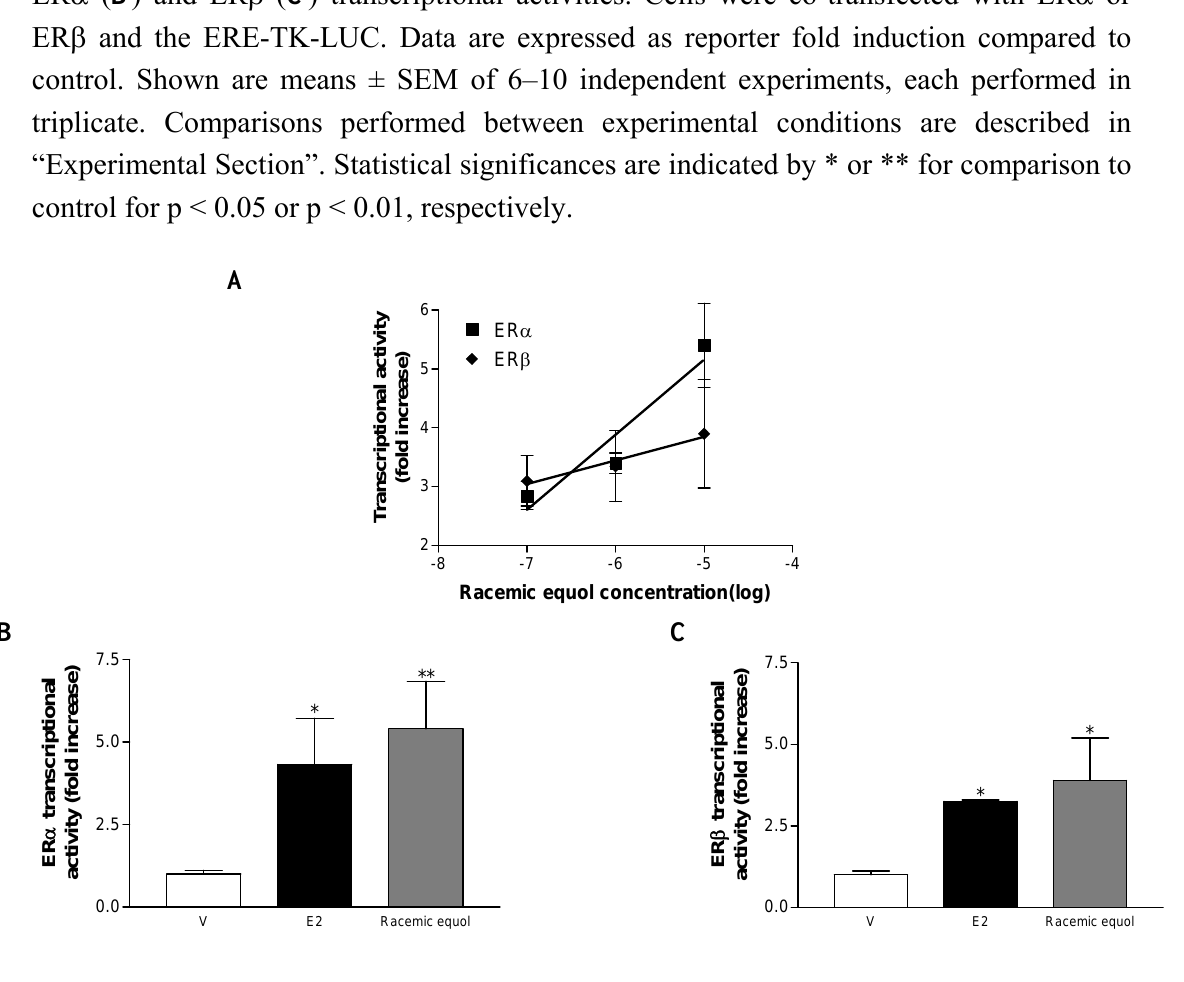
Figure 2. Transcriptional activation of ER by racemic equol in CHO cells. The effects